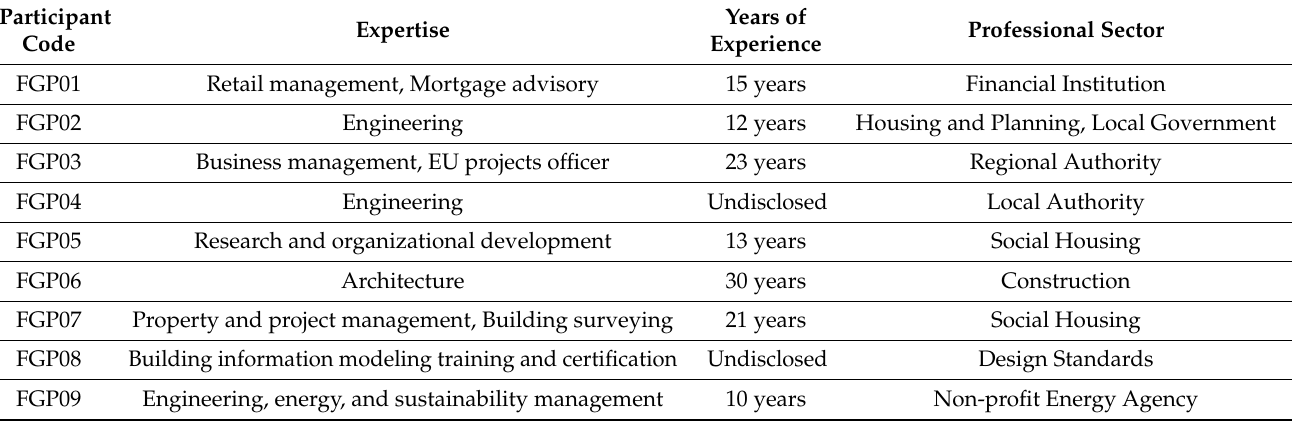
Table 3. Focus group participant profiles.